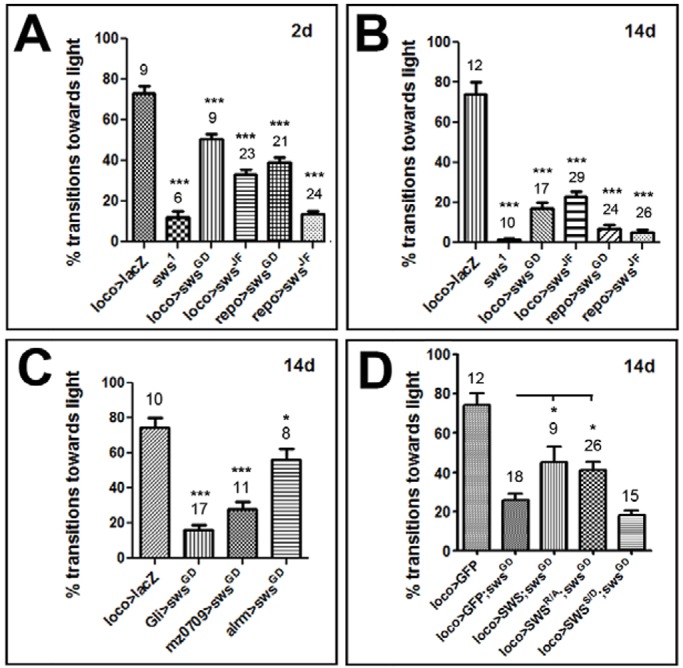
Loss of SWS in glia causes defects in the fast phototaxis assay. Pan-glial SWS knockdown flies show less successful transitions in fast phototaxis assays already at 2 days of age (A) that are further reduced when 14 days old (B). (C) Deficits in the fast phototaxis assay are also observed in glial-subtype-specific SWS knockdown flies. (D) Expression of SWSR/A suppresses the phototaxis phenotype in the 14-day-old glial knockdown, whereas SWSS/D does not. Number of tested groups (with five to ten flies) and s.e.m. are indicated. *P<0.05, ***P<0.001.